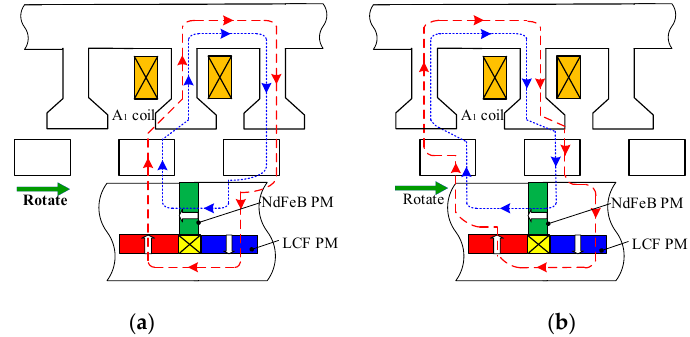
Figure 2. Switched-flux principle of proposed PS-SF-HMMM. ( a ) Rotor position A; ( b ) Rotor position B.